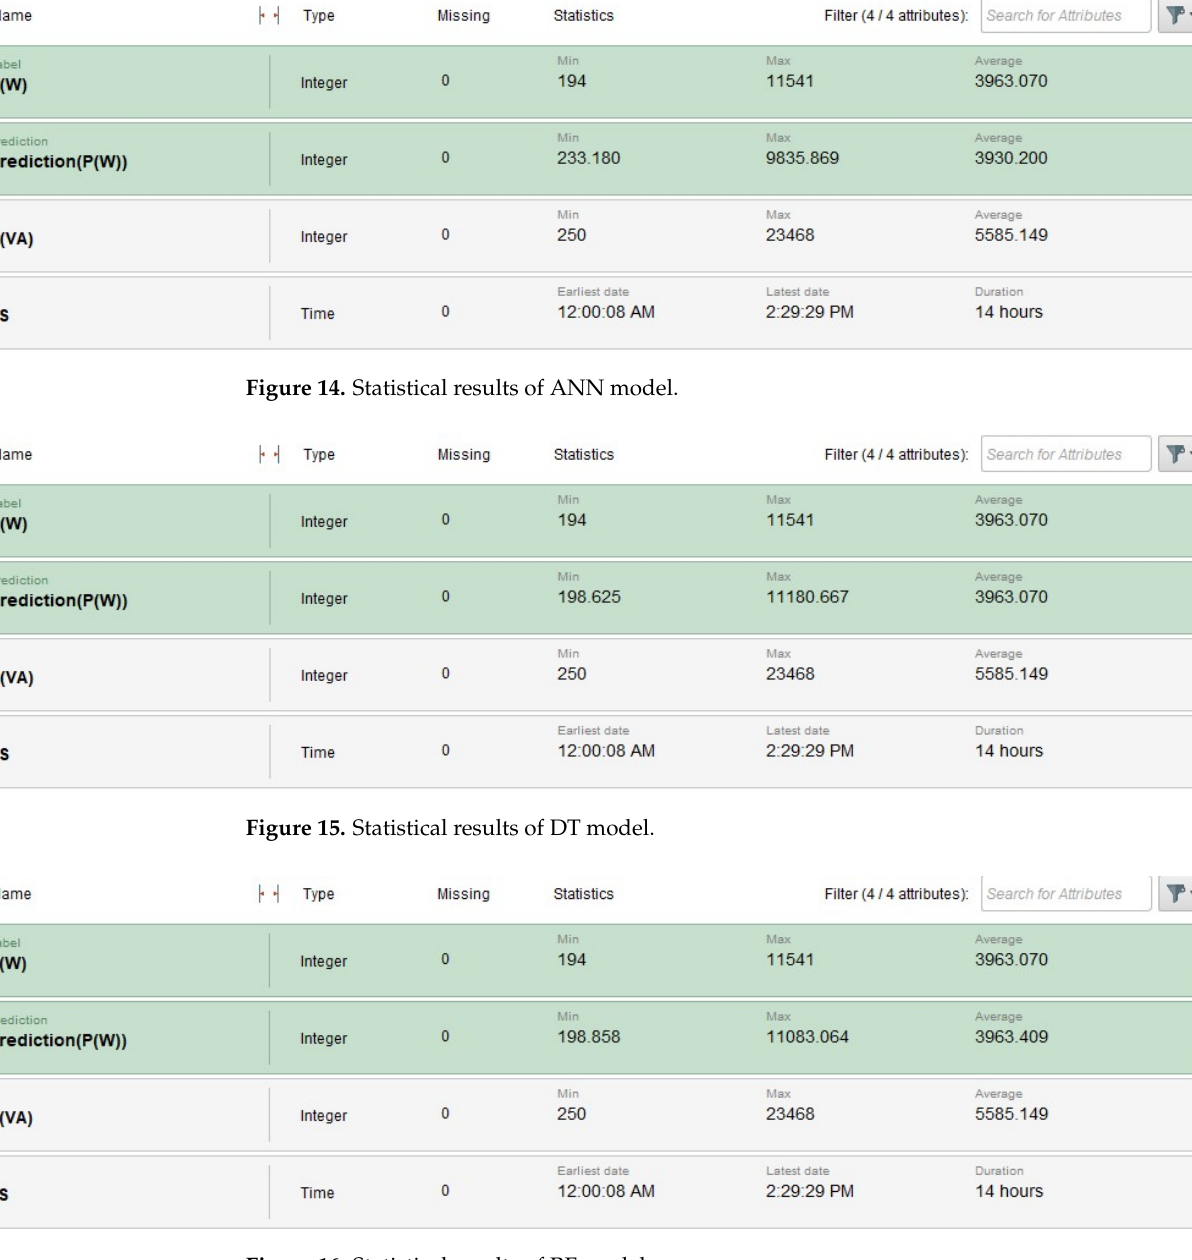
Figure 16. Statistical results of RF model.